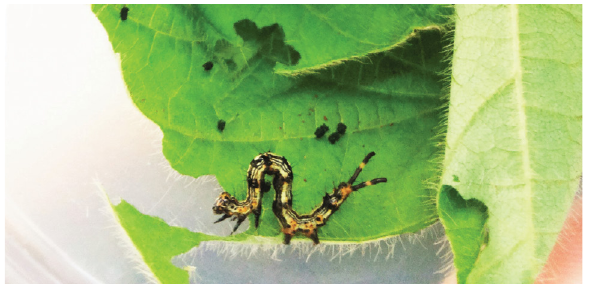
Figure 1. Caterpillar Selenisa sueroides (Guenée, 1852) (Lepidoptera: Noctuidae).